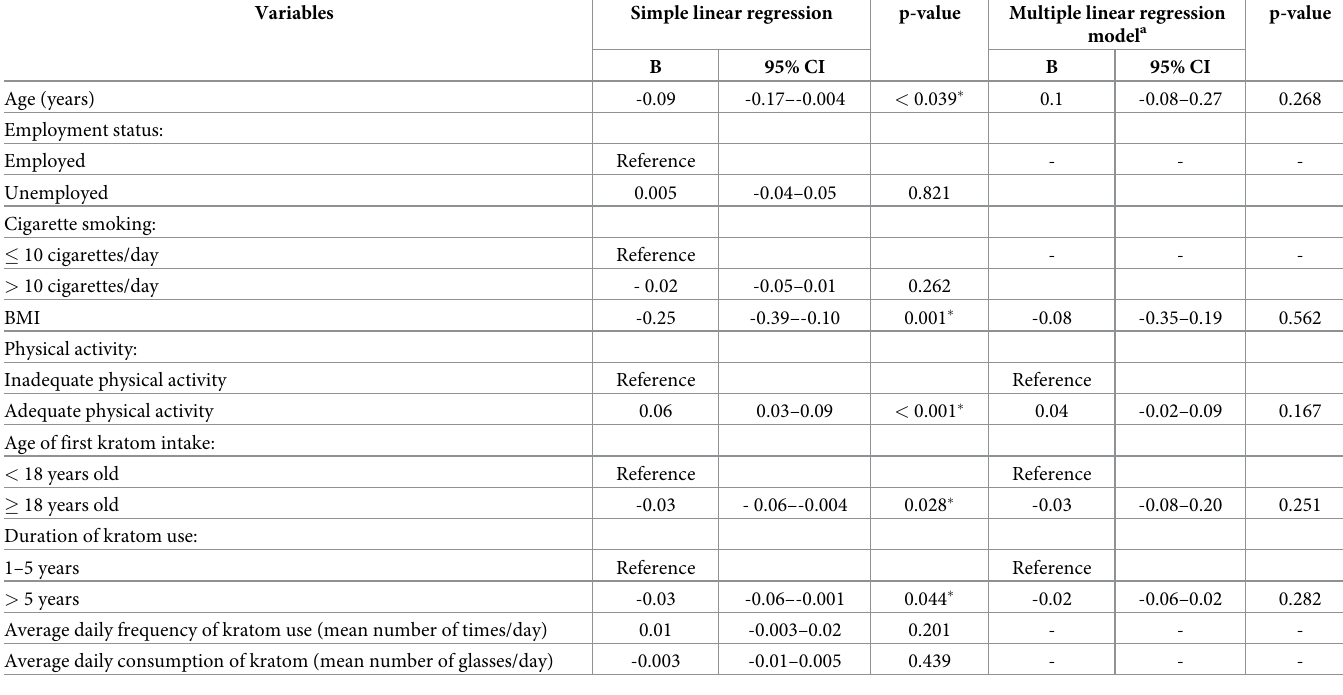
Table 7. Association between kratom use characteristics and serum HDL level among kratom users, accounting for confounding factors such as age, employment status, cigarette smoking, physical activity, and